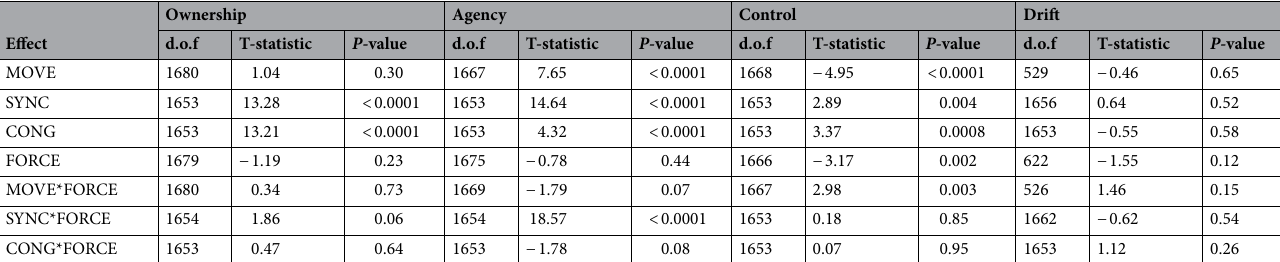
Table 1. Statistical results for Study I. SO ratings, SA ratings, control ratings and proprioceptive drifts (Study I only) are modelled as a function of the experimental factors ("movement type", "synchrony" and "congruency") and the